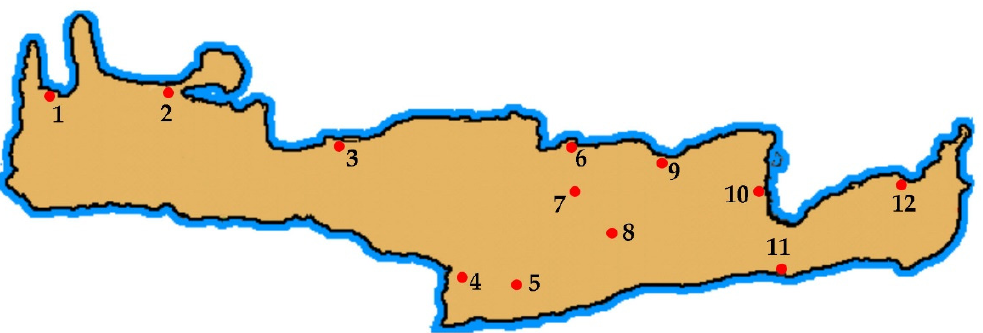
Figure 14. The geographical location of the cities or towns of Crete Island with populations of more than 3000 inhabitants and the corresponding locations of the biogas-fired CHP plant’s installation.